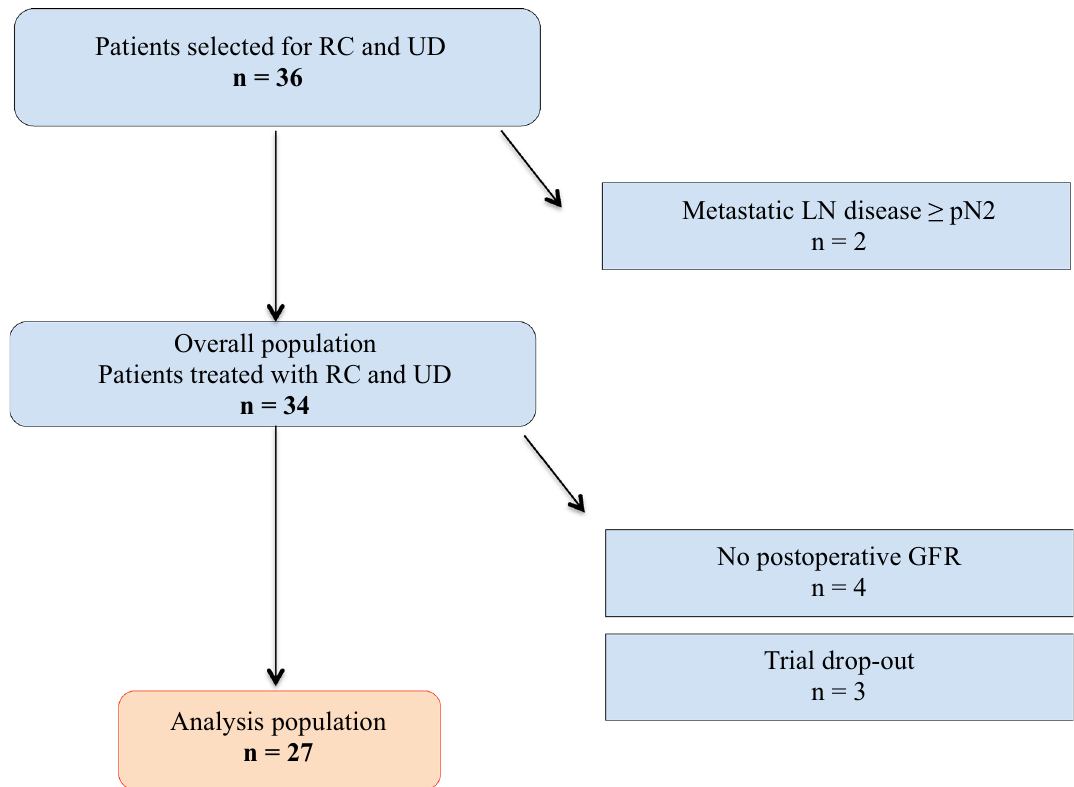
Figure 1. Flow chart of the study. RC radical cystectomy, UD urinary diversion, GFR glomerular filtration rate, LN lymph